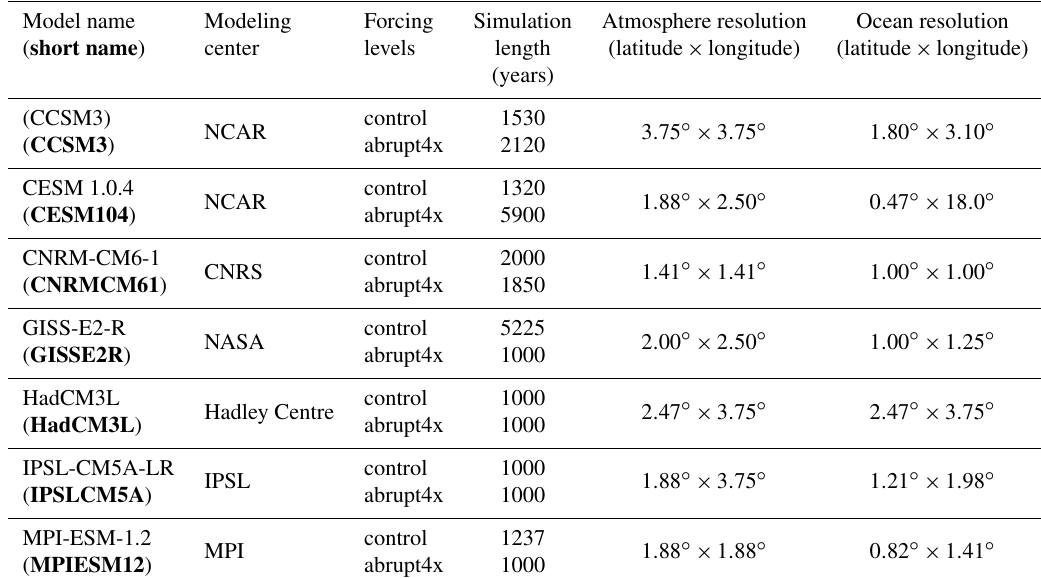
Figure 1. (a–h) Time series of Niño3.4 mean TAS and (g) CO 2 concentrations in the control and abrupt4xCO 2 simulations. The dashed lines mark the year 150, the period after which we assume a quasi-equilibrium. Table 1. Overview of model simulations. The bold text represents the short name of the